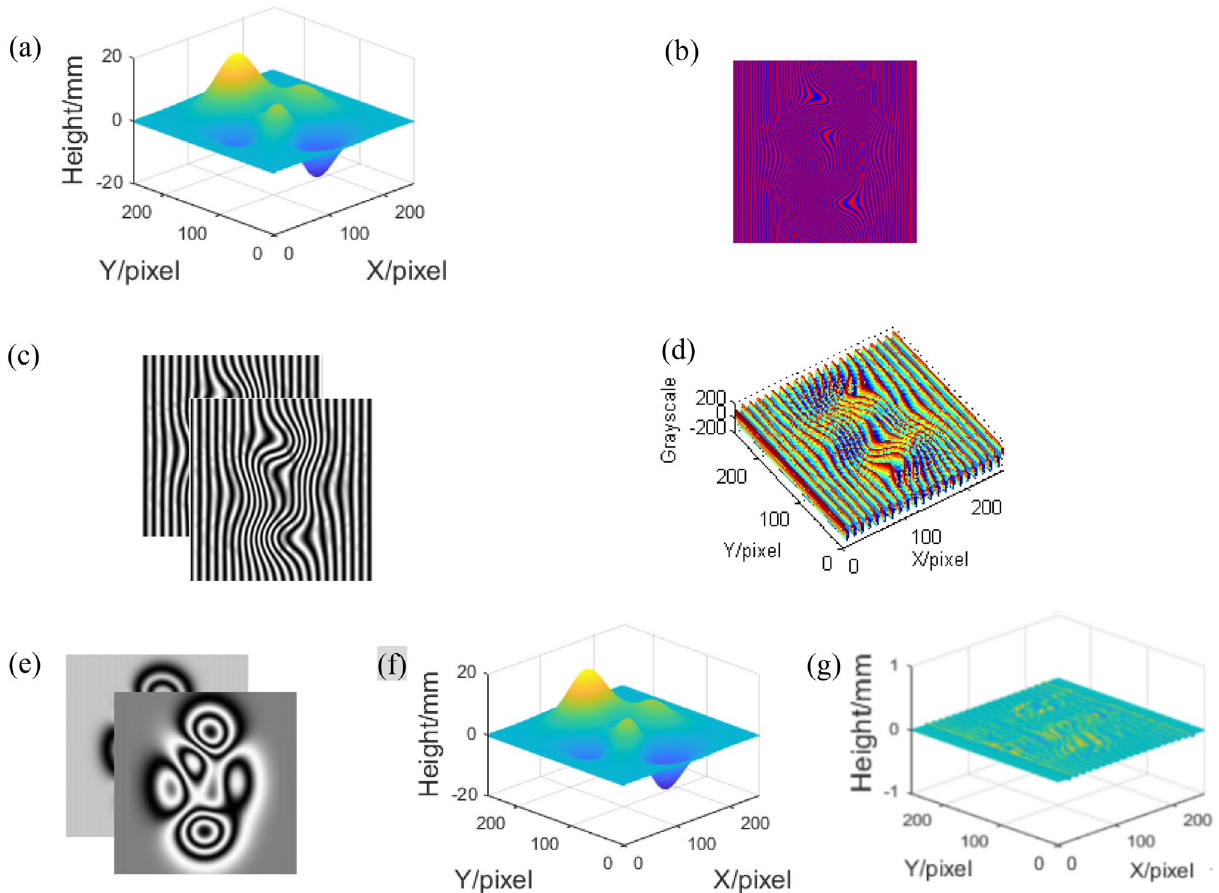
Figure 4. Simulation of color-encoded single-shot computer-generated Moiré profilometry: ( a ) the measured peaks; ( b ) the color deformed pattern of the peaks; ( c ) the red and blue components after normalization of the peaks; ( d ) the AC component I AC of the peaks; ( e ) the Moiré0 and Moiré90 fringes of the peaks; ( f ) the reconstructed peaks; ( g ) the error with Fig. 5a is put on the reference plane, and the designed composite color grating is projected onto the star. The corresponding color deformed pattern is captured by the CCD camera as shown in Fig. 5b, and it is also saved on the computer. After the red component and the blue component are separated from the color deformed pattern, the normalized deformed patterns are as shown in Fig. 5c. The AC component of the red normalized deformed pattern can be get as shown in Fig. 5d. Two computer-generated Moiré fringes are as shown in Fig. 5e. Finally, the 3D shape of the measured star model can be reconstructed, and the reconstructed result is shown in Fig. 5f.